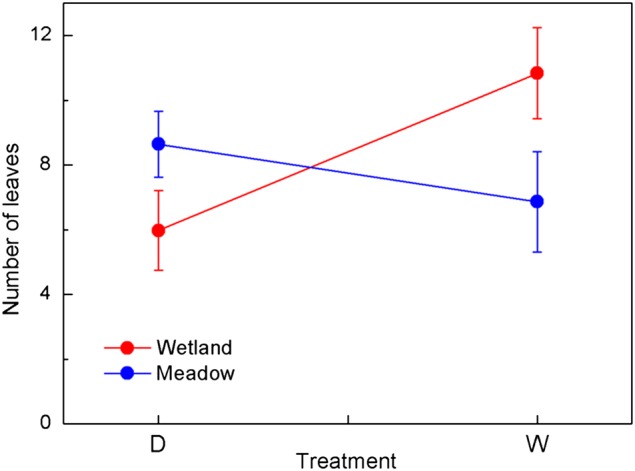
Number of leaves (means ± 1 SE, a proxy for growth) that emerged after treatment was applied for wetland and meadow species in different water treatments. Red line indicates wetland species and blue line meadow species. Abbreviations: D, dry-down treatment; and W, waterlogged treatment.